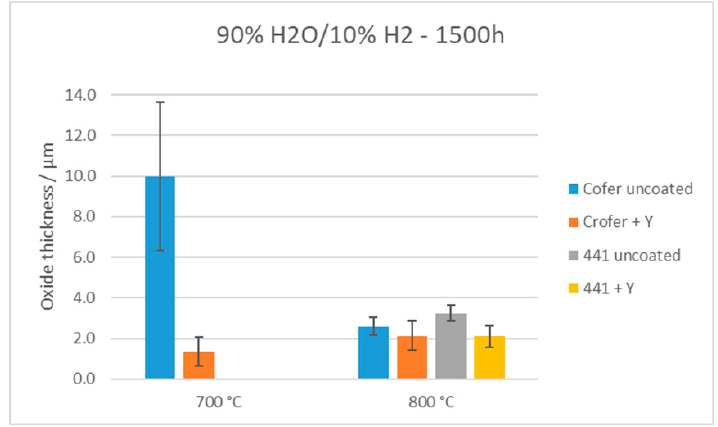
Figure 16. Average oxide scale thicknesses for samples tested in H 2 -H 2 O atmosphere with standard deviations. For uncoated Crofer 22 APU at 700 °C, the thickness of the porous Fe-oxide layer is included.